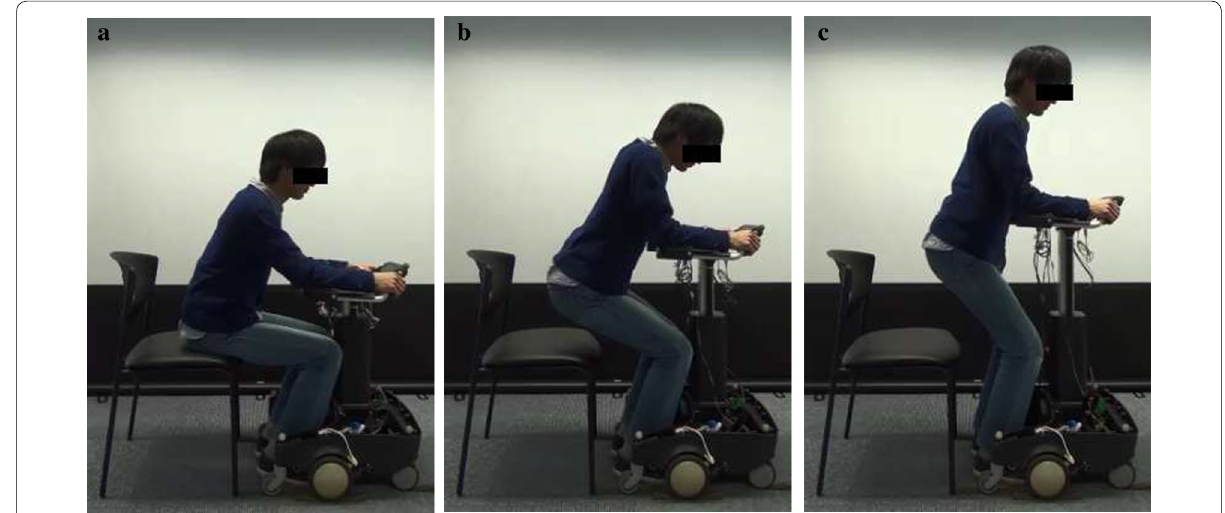
Fig. 2 Sit‑to‑Stand motion [6]. Lateral views of sitting, rising, and standing (from left to